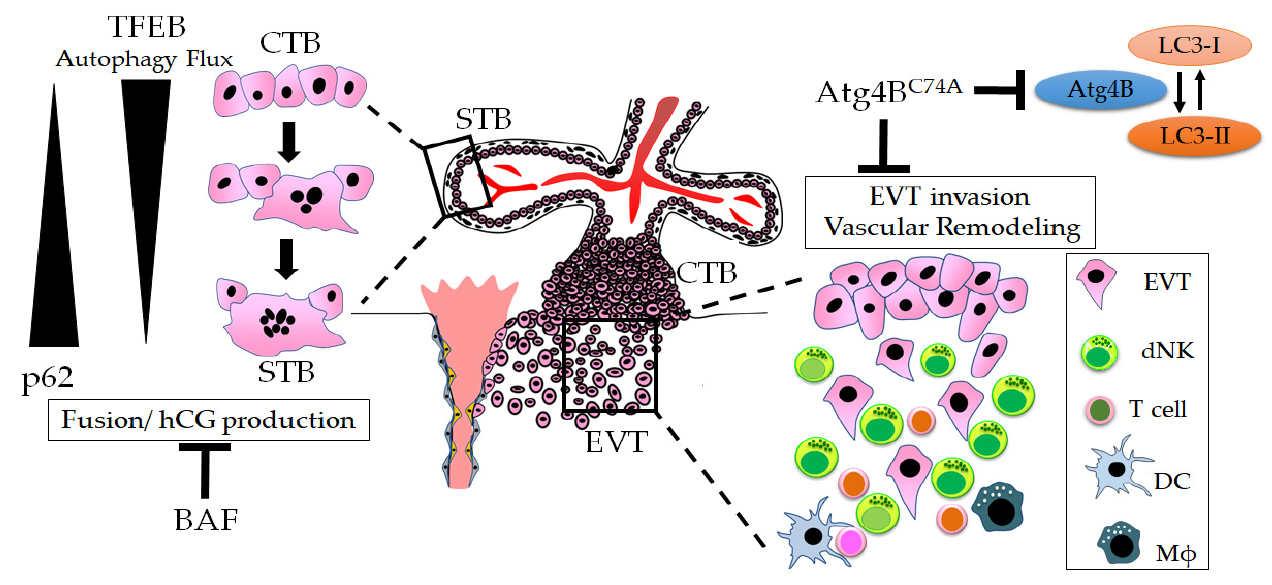
Figure 3. The roles of autophagy in early placentation. Autophagic activity is decreased during syn- cytialization in the in vitro model. BAF inhibited syncytial fusion and human chorionic gonadotropin (hCG) production in STB. EVT cells invade into decidualized endometrium under hypoxia, and face various types of maternal immune cells, such as decidual NK (dNK) cells, T cells, dendritic cells (DC), or macrophages (M Φ ). Invasion and vascular remodeling are inhibited in EVT cells trans- duced with the Atg4B C74A mutant. STB, syncytiotrophoblasts; CTB, cytotrophoblasts; EVT, extravil- lous trophoblasts.